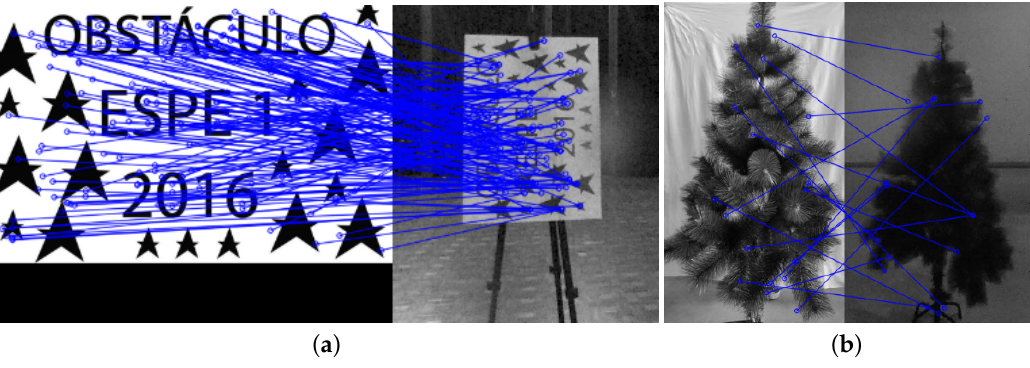
Figure 3. Feature point matching. ( a ) Pre-designed obstacle; ( b ) obstacle present in the